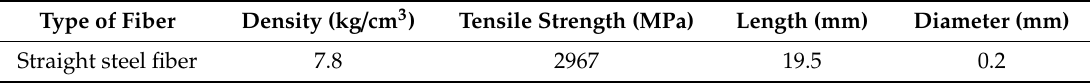
Table 2. Physical properties of steel